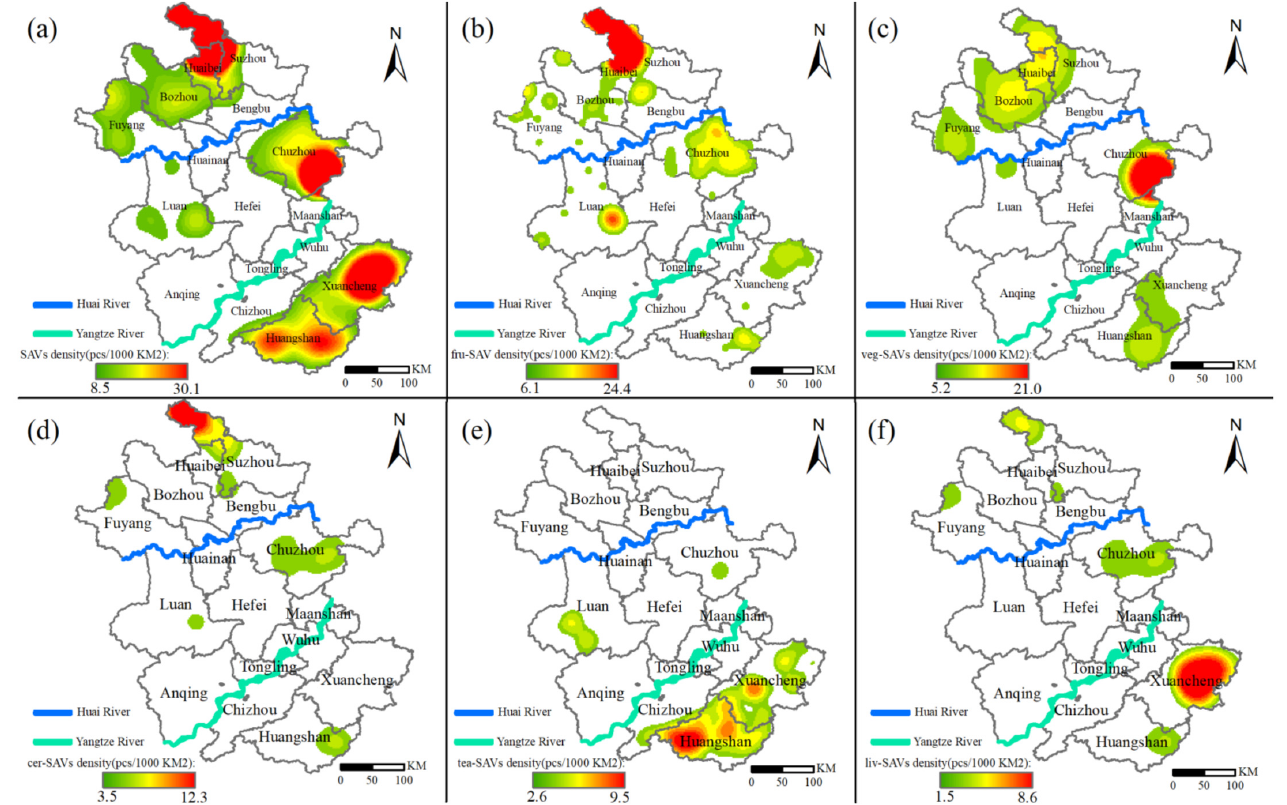
Figure 3. The spatial distribution of SAVs ( a ), fru-SAV ( b ), veg-SAV ( c ), cer-SAV ( d ), tea-SAV ( e ) and liv-SAV ( f ). Using kernel density distribution as a selection criterion, we partitioned the SAVs in their highest distributed areas for better representation of their attributes, which was used for the subsequent RFR analysis. The respective density thresholds for the fru- SAV, veg-SAV, cer-SAV, tea-SAV, and liv-SAV were 16.8 pcs/1000 km 2 , 14.4 pcs/1000 km 2 , 9.1 pcs/1000 km 2 , 7.0 pcs/1000 km 2 , and 6.1 pcs/1000 km 2